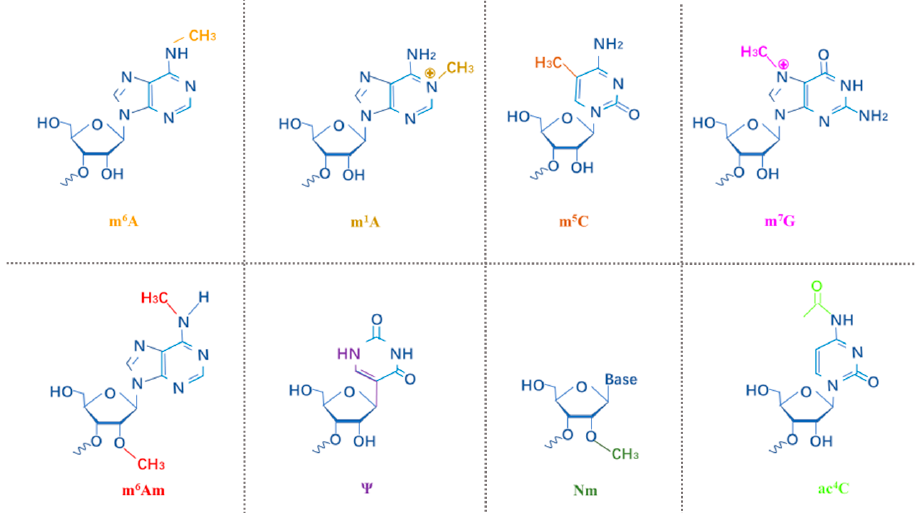
Figure 1. The structure of modifications in RNA. The indicated epitranscriptomic marks are m 6 A, m 1 A, m 5 C, m 7 G, m 6 Am, Ψ , Nm and ac 4 C.